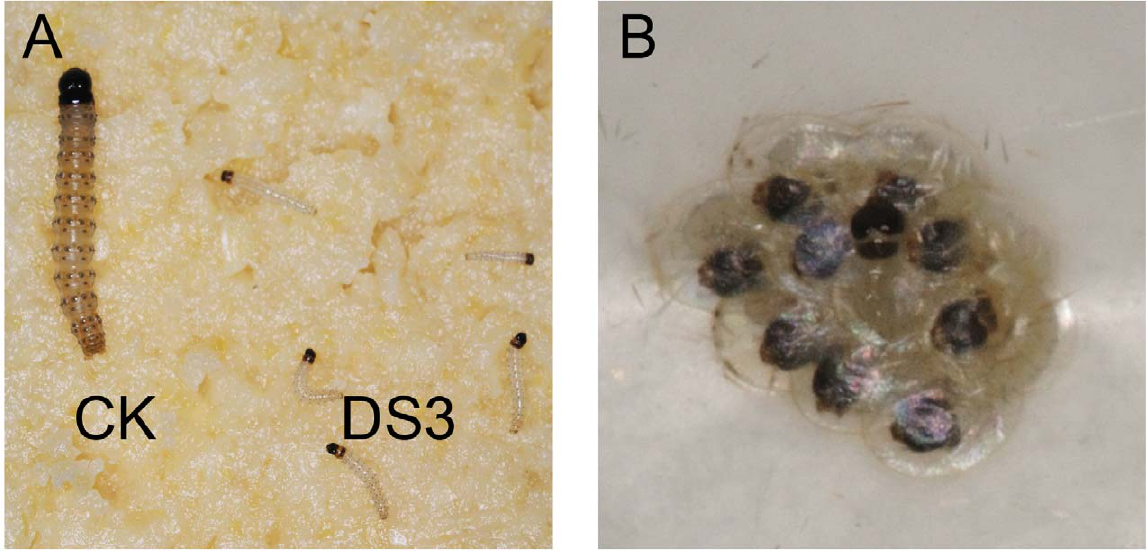
Figure 3. The eggs were soaked in dsRNA solutions or the dsRNA was sprayed on larvae. ( A ) When 20 ng/ m l dsRNA (DS3) feeding solution was sprayed on the larvae, the development of the treated larvae was stunted remarkably. CK (left side): one of the control larvae reaching third instar 7 d after spray with dsRNA blank buffer, DS3 (right side): the larvae remaining in first instar 7 d after spraying dsRNA of DS3 gene; ( B ) The egg masses were soaked in 50 ng/ m l dsRNA solution for 2h, the embryos could develop, but most of them were not able to hatch.